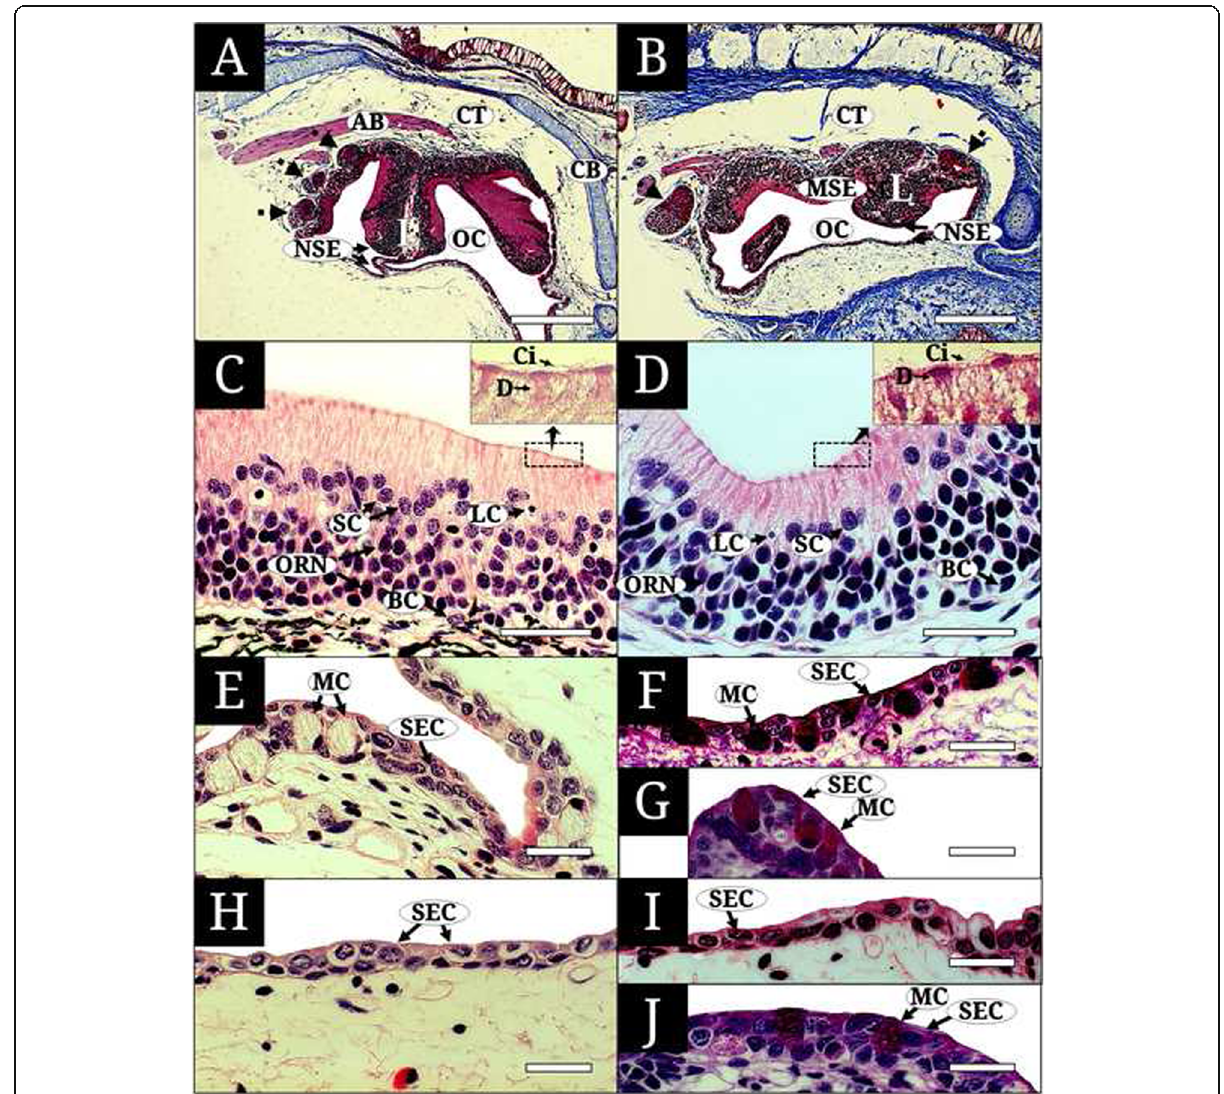
Fig. 2 Histological characteristics of the cross-sectioned main olfactory organ in two lungfishes, Protopterus amphibius and P. dolloi , stained with hematoxylin and eosin ( c , d, e, h ), alcian blue (pH 2.5)- periodic acid Schiff ( f, g, i, j ), and Masson ’ s trichrome ( a, b ). a , the main and accessory olfactory organs of P. amphibius ; b , the main and accessory olfactory organs of P. dolloi ; c , the sensory epithelium of the main olfactory organ of P. amphibius ; d , the sensory epithelium of the main olfactory organ of P. dolloi ; e, f , the lateral non-sensory wall of the olfactory chamber of P. amphibius ; g , the non-sensory epithelium of lamella of P. amphibius ; h, i , the lateral non-sensory wall of the olfactory chamber of P. dolloi ; j , the non-sensory epithelium of lamella of P. dolloi . BC, basal cell; Ci, motile cilia; D, dendrite; LC, lymphatic cell; MC, mucous cell; ORN, olfactory receptor neuron; SC, supporting cell; SEC, stratified epithelial cell. The bars indicate 500 μ m in ( a and b ), 50 μ m in ( c - j